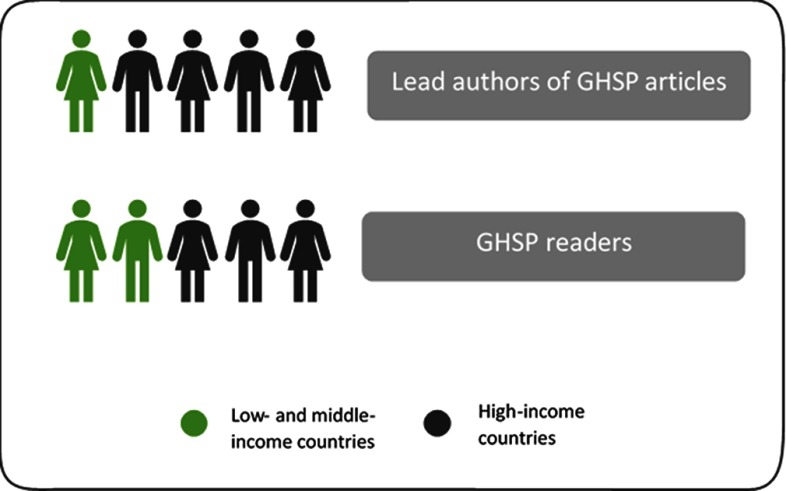
Current Reach of GHSP Into Low- and Middle-Income CountriesSource: Data on lead authors from administrative data and on GHSP readers from Google Analytics data (total sessions from March 2013 through April 2017).